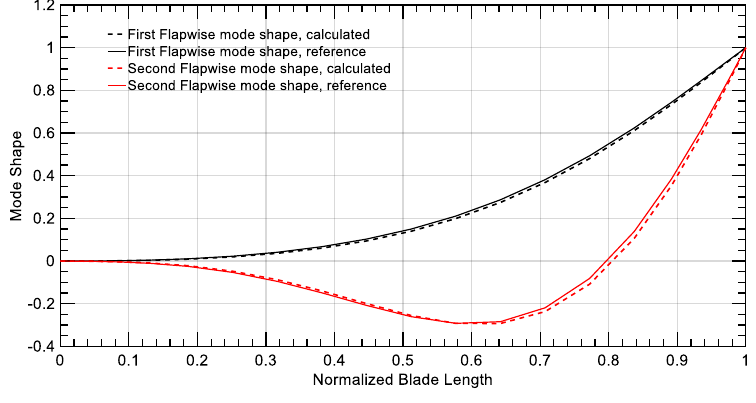
Figure 6. Blade flap-wise mode shapes.